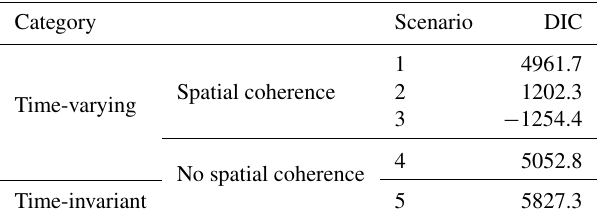
Table 4. Comparison of five scenarios in terms of the deviance in- formation criterion (DIC) when model parameters were calibrated in the wet years and verified in the dry years.